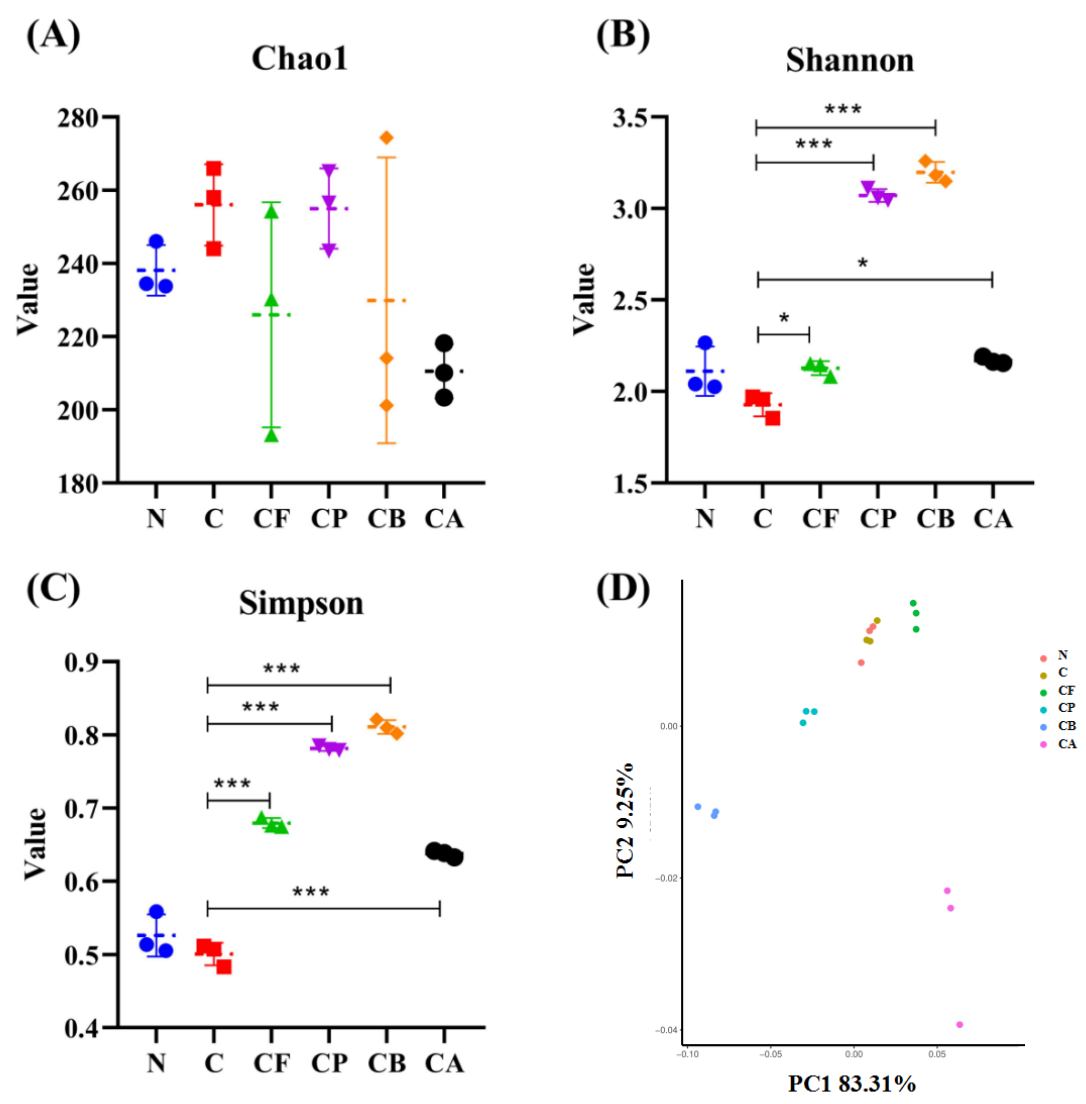
Figure 4. Analysis of different microbial α -diversity and β -diversity indices in the six experimental groups. The Chao1 ( A ) index was used as richness estimators. The Shannon ( B ) and Simpson ( C ) indices were used as diversity estimators. Principal Coordinates Analysis (PCoA) ( D ) was based on the weighted UniFrac distance matrix generated from all the samples in each group. Asterisks indicate significant difference between fermentation with C3G only and with C3G mixed with different polysaccharides according to an ordinary one-way ANOVA: * ( p < 0.05), and *** ( p < 0.001). Values are means ± SD for n = 3, as below.